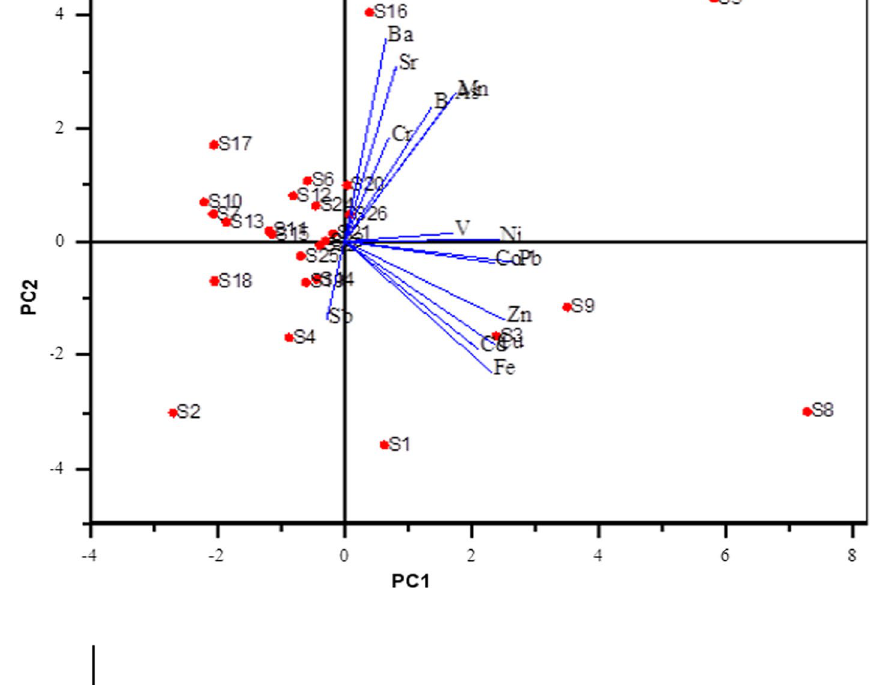
Fig. 3 Dendrogram from the cluster analysis of 15 ele- ments in 26 sampling sites on the Akaki River and its main